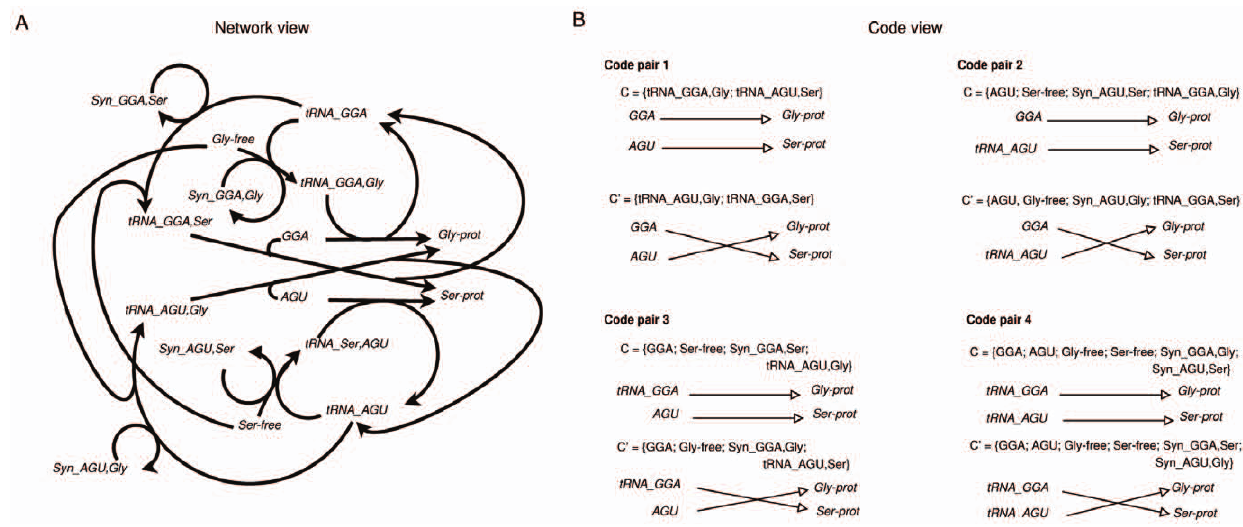
Figure 2. Subnetwork of the full gene translation network model with synthetases ( N GC ) and the realized molecular codes. The network (panel A) shows a subnetwork of the gene translation network model containing the translation, and loading reactions for two selected codons (GGA, AGU) and amino acids (Gly, Ser). The semantic analysis shows that four code pairs can be implemented by this network (panel B). doi:10.1371/journal.pone.0054694.g002 PLOS ONE |